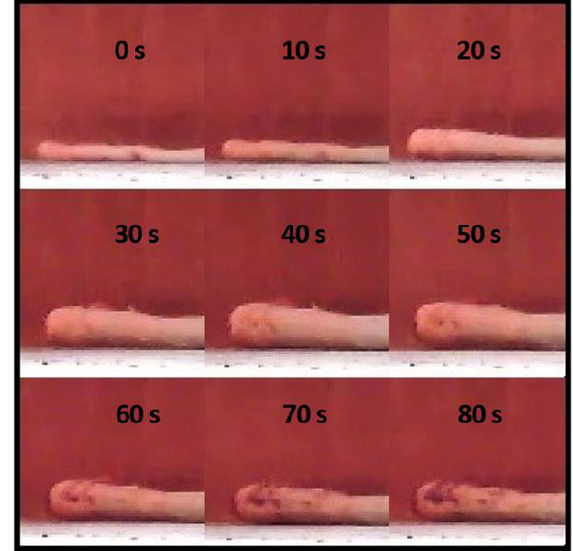
Figure 1. Cross section pictures of the pizza crust topped with tomato sauce and sunflower oil (pizza sample D: cf. Table 1) at different baking times in the range of 0 to 80 s.